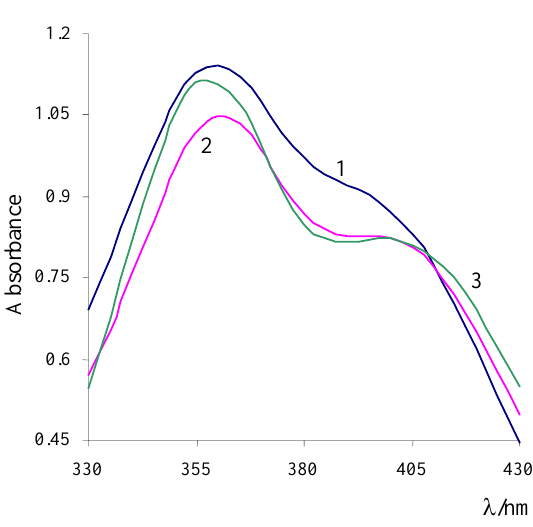
Figure1. Absorption spectra of R – species of α -DNP (7.38 × 10 –5 M) in water (1), in 2.5 × 10 –3